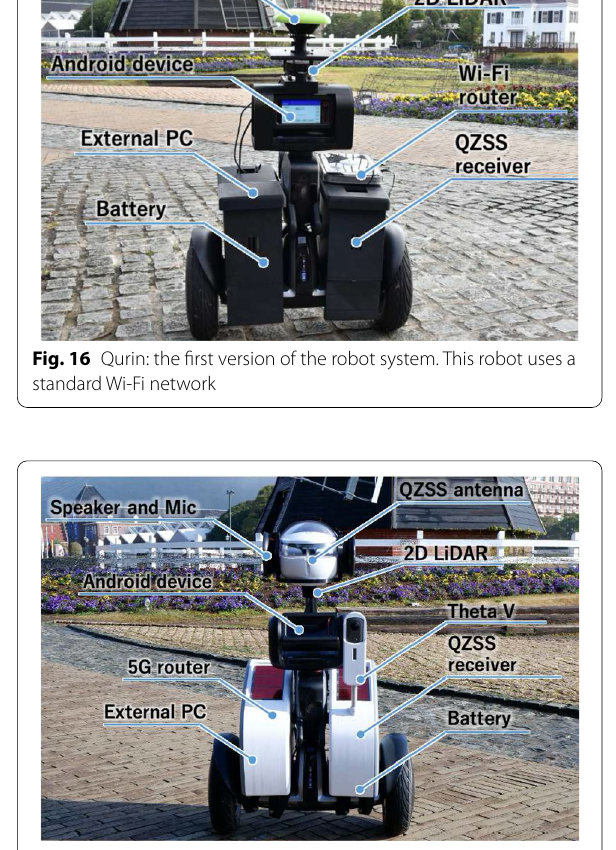
Fig. 17 Quriana: the second version of the robot system. This robot uses a 5G